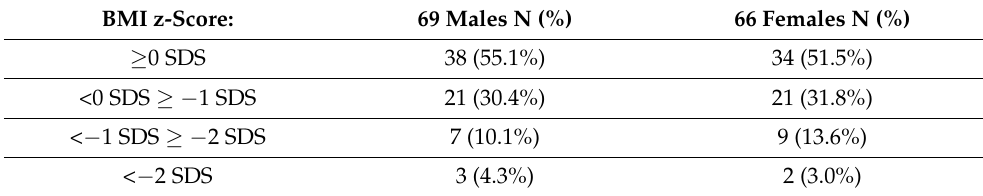
Table 2. BMI z-scores classes in age group 2–18 years. BMI